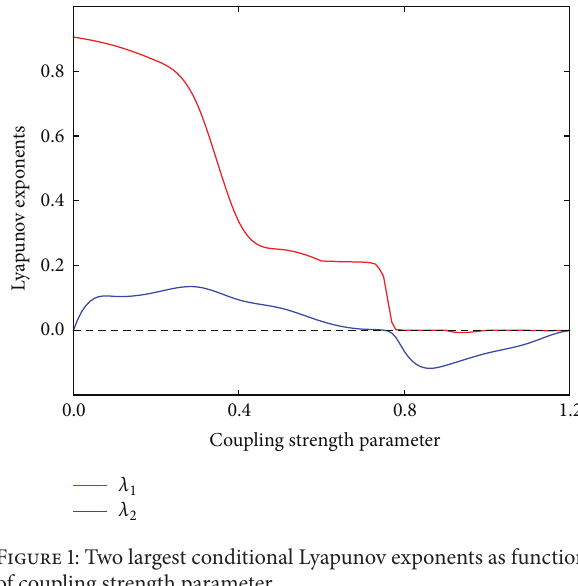
Figure 1: Two largest conditional Lyapunov exponents as functions of coupling strength